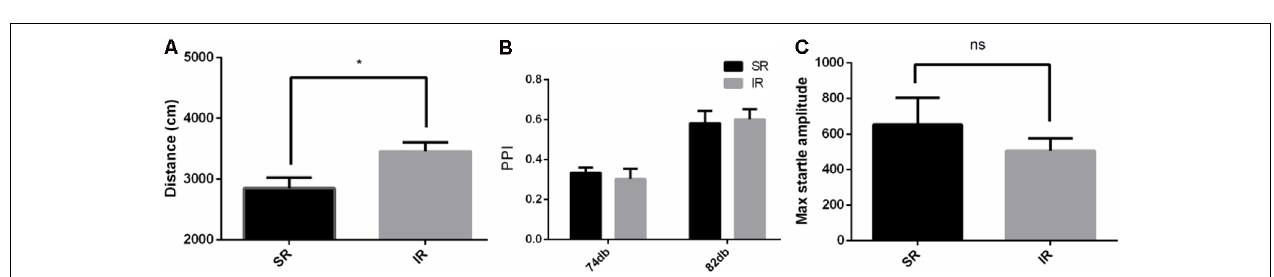
FIGURE 2 | Effects of isolation rearing on the CX3CR1 expression in the wild-type mice. Different regions were tested, including the mPFC (A) , NAc (B) , and HIP (C) . The results are expressed as the mean ± SEM ( n = 6 for the SR group and n = 6 for the IR group. * p < 0.05, ** p < 0.01, *** p < 0.001, student’s t -test).